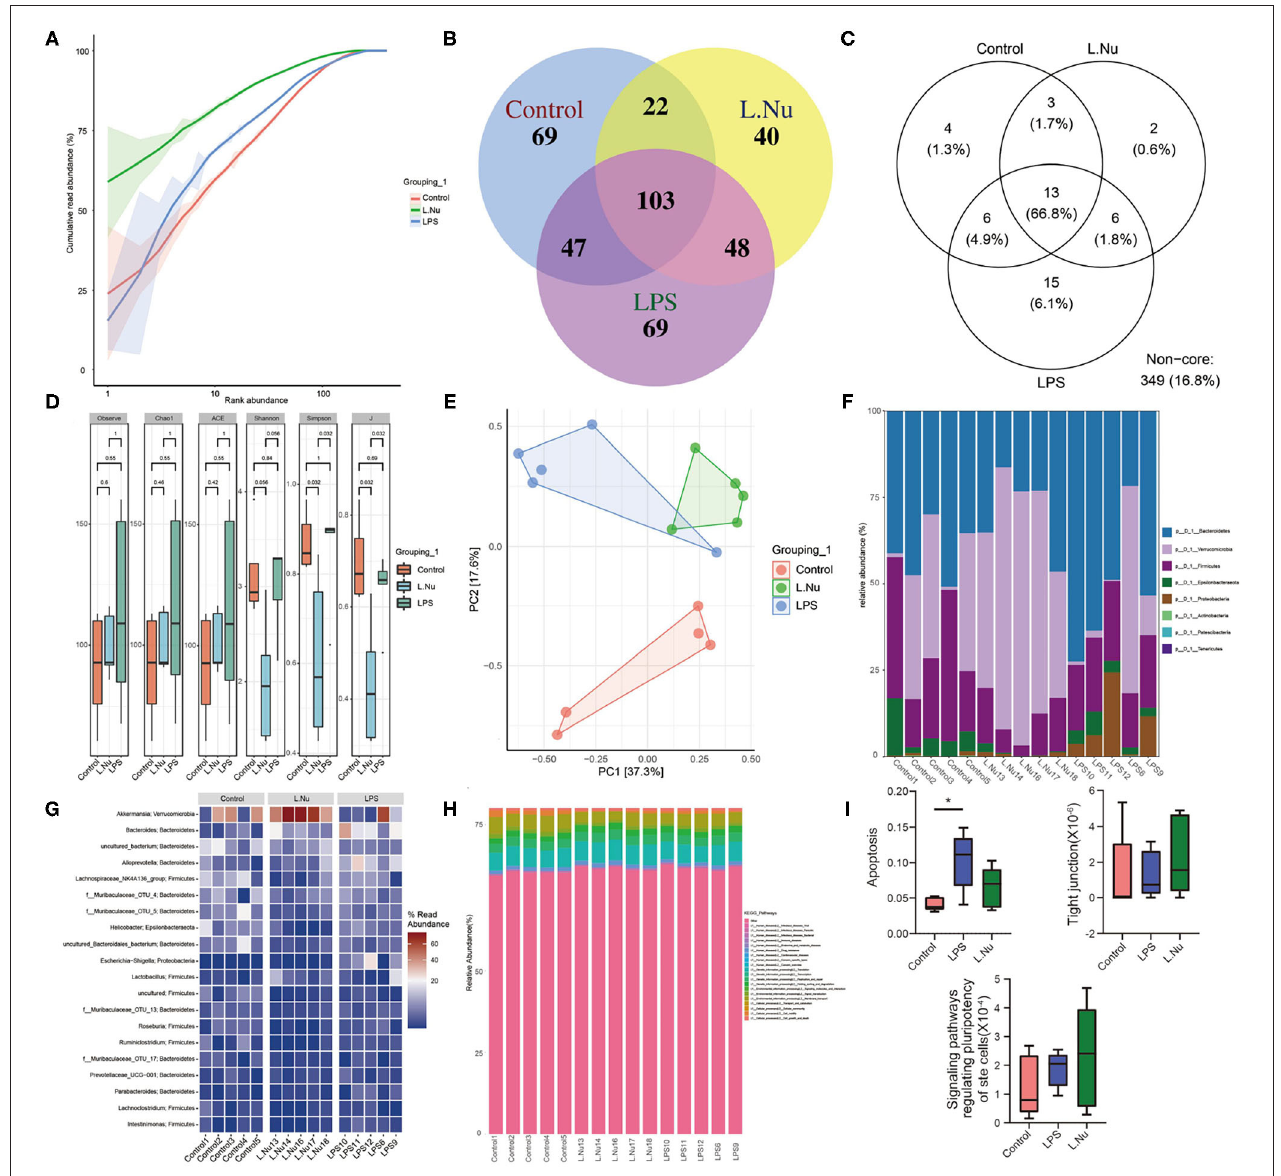
FIGURE 4 | NU9056 affected the fecal microbiota in LPS-induced mice. (A) Rank-abundance graph. (B) Venn diagram of the number of common and unique OTUs in each group. (C) Venn diagram of the number of common and unique core species OTUs in each group. (D) The alpha diversity of gut microbiota in each group was analyzed using 16S rDNA sequencing, consisting of (1) Observed OTUs, (2) Chao1 index, (3) ACE index, (4) Shannon index, (5) Simpson’s index, and (6) J index. (E) Principal component analysis of the similarity of samples among groups. (F) Variation in the relative abundance of samples in each group at the phylum level. (G) Variation in the relative abundance of samples in each group at the genus level. (H) KEGG pathways predictions of functions of gut microbiota at the class level. (I) KEGG pathways predictions of enrichment of each group in apoptosis, tight junction, and signaling pathways regulating the pluripotency of stem cells. * P <